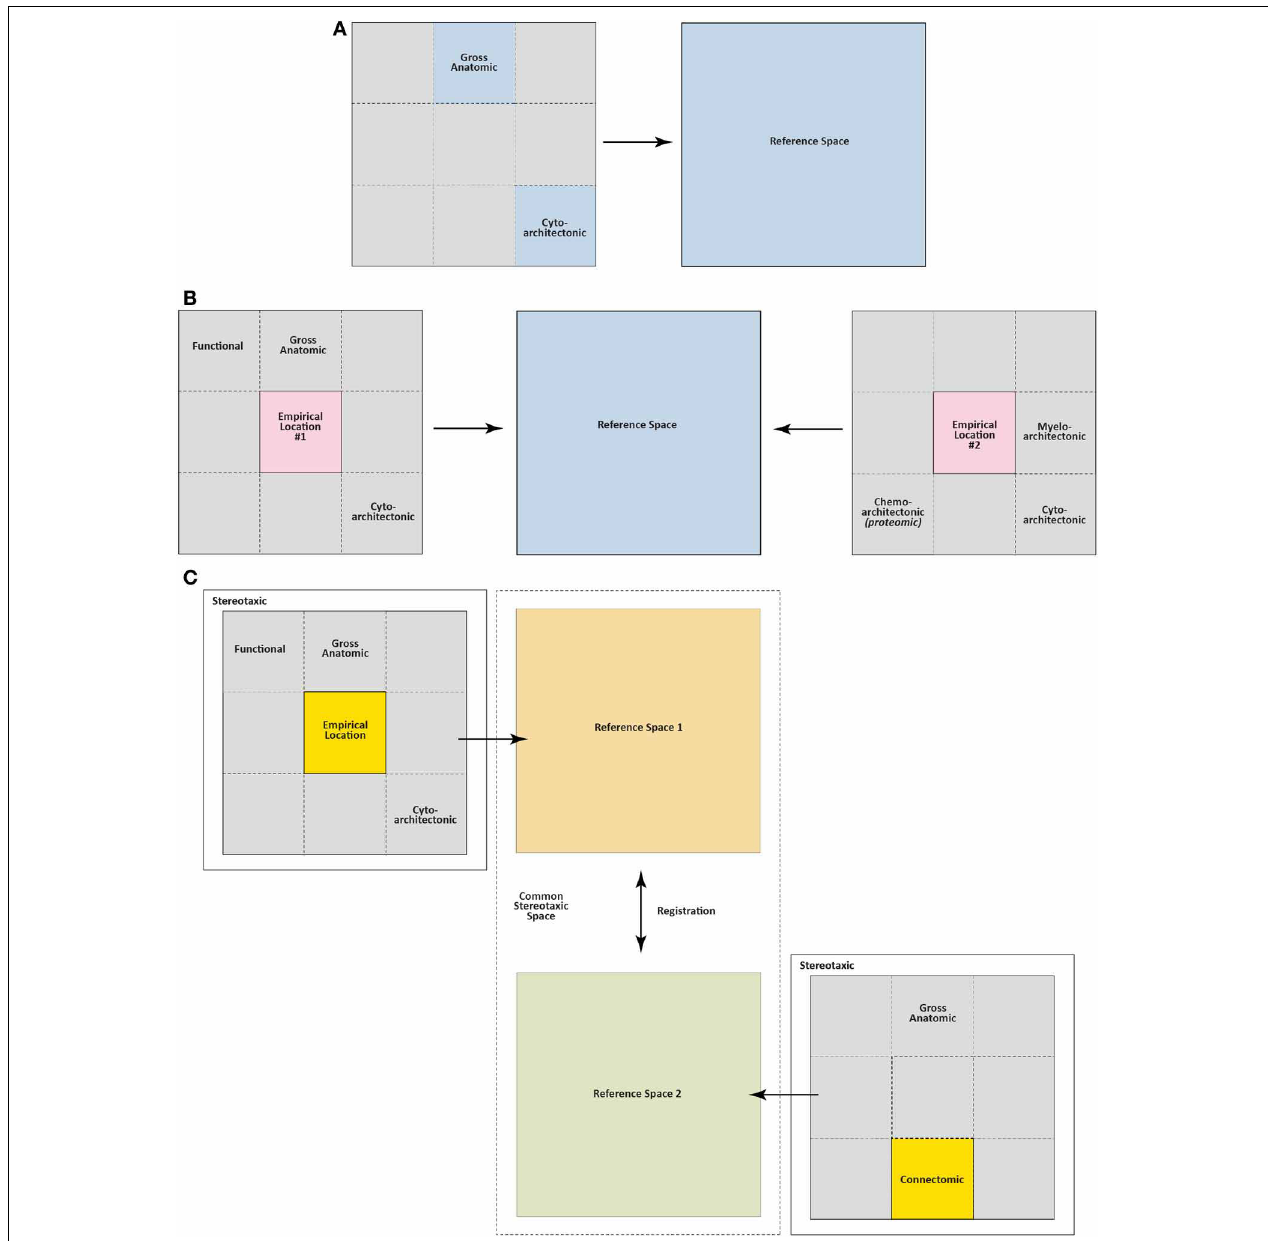
FIGURE 6 | Reference space, stereotaxic space, and anatomical registration. (A) A reference space derived from the spatial analysis of a rodent brain. In this case, the visualizable spaces used to create the reference space include gross anatomic space and cytoarchitectonic space . (B) “Scenario One” for inter-brain registration, as described in Reference space as a solution to the first scenario. Mapping of two empirical locations (injection sites, for example) from two different brains to a common